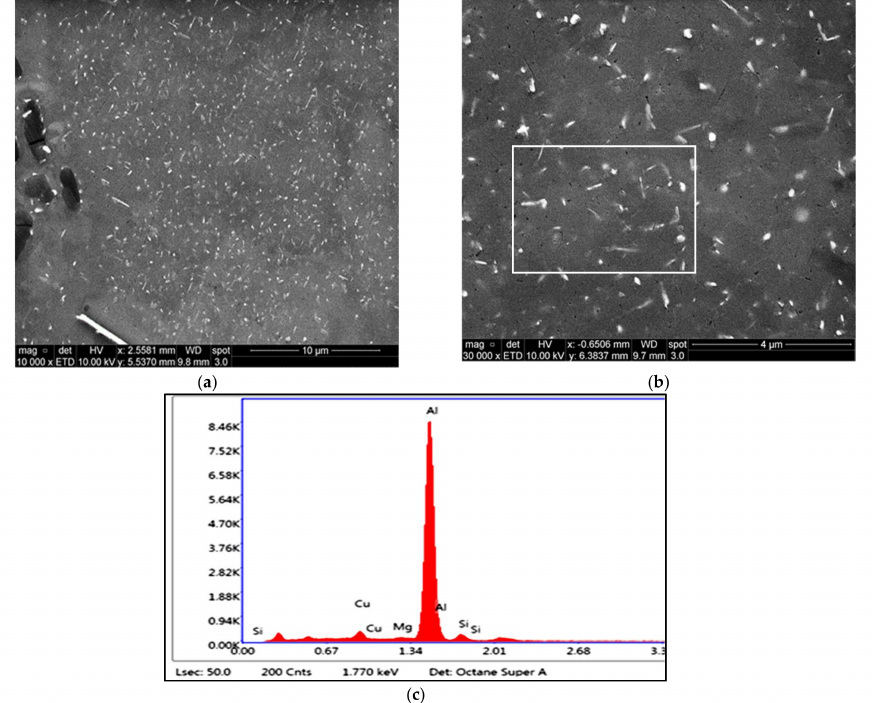
Figure 8. ( a , b ) Backscattered electron images at different magnifications showing the size and distribution of precipitates in the T6-treated M1S alloy after stabilization at 250 ◦ C for 200 h; ( c ) EDS spectrum corresponding to the rod-like particles in white square in ( b